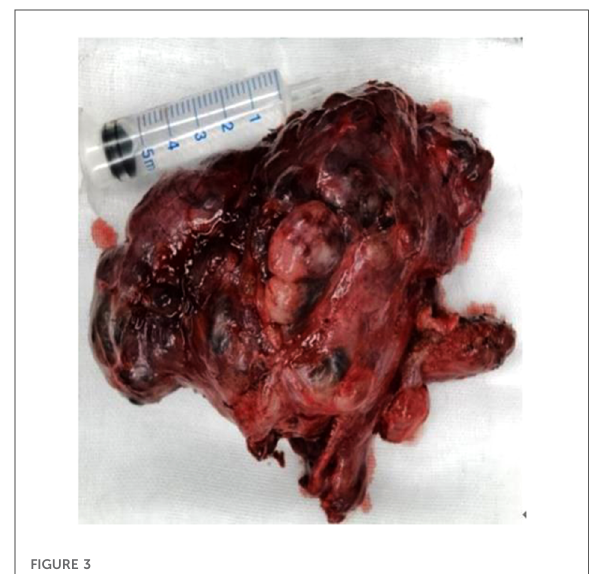
FIGURE 3 Resected thyroid gland from the patient.